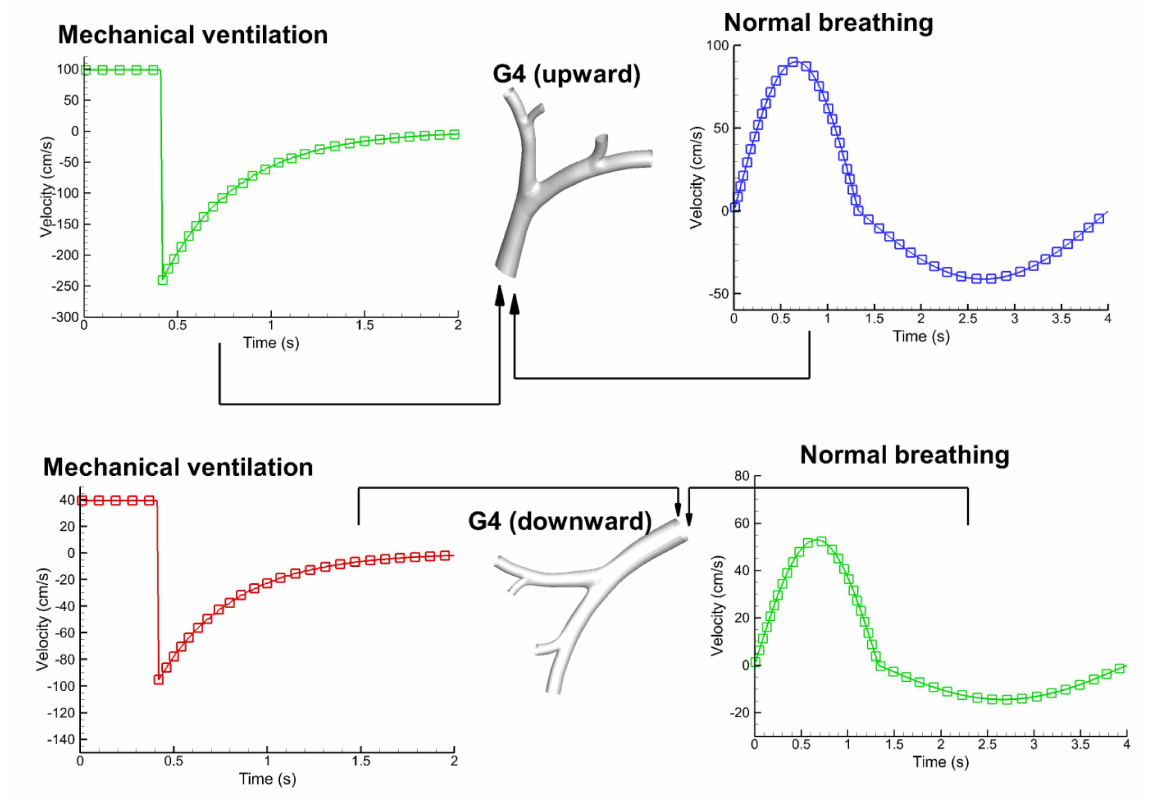
Figure 13. Comparison of bifurcation waveforms. The waveforms used for MV and the NB at the upward bifurcation ( top ) and downward ( bottom ) bifurcation for fourth generation in the right